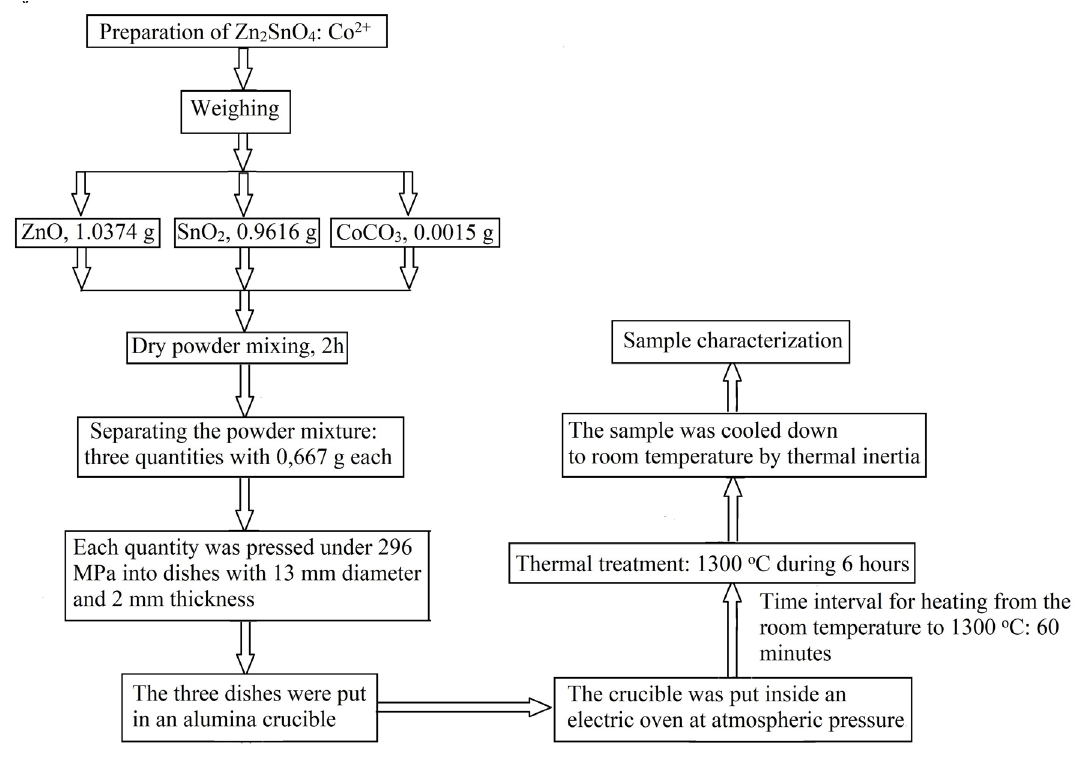
Figure 1. Flowchart of sample preparation.